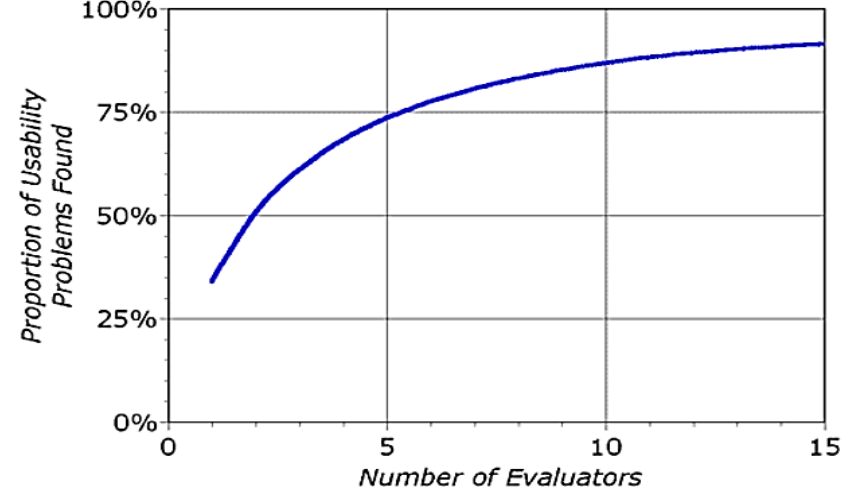
Fig. 1. Usability problems found by heuristic evaluation with various numbers of evaluators as averaged from six case